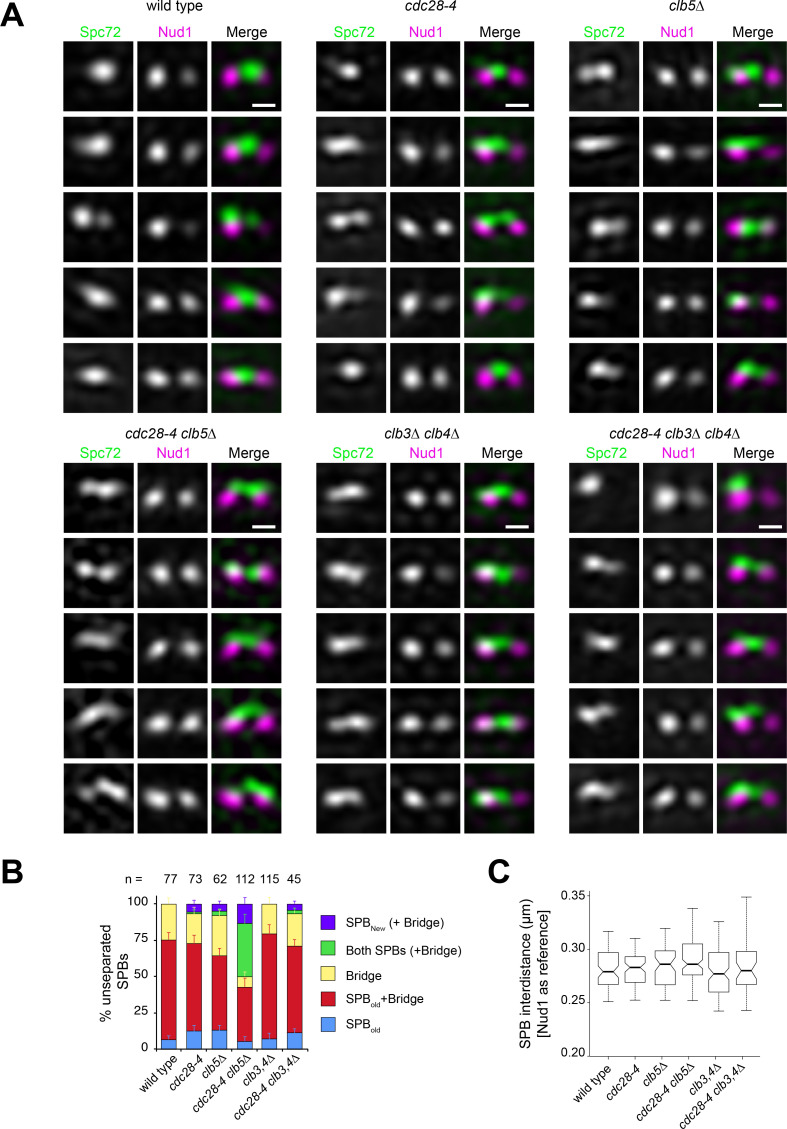
S phase CDK inactivation anticipates Spc72 recruitment at the new outer plaque in unseparated SPBs.Wild-type and cdc28-4 and cyclin mutant strains containing Spc72-Venus (green) and Nud1-mT2 (magenta) were imaged by SIM and subject to 3-D Gaussian fit and realignment, in reference to Nud1, to determine the distribution of Spc72 relative to Nud1. (A) Representative SIM images showing unseparated SPBs. Scale bar, 200 nm. (B) Quantitation of Spc72 distribution in all strains analyzed. Bars, standard error of the proportion. (C) Boxplot for distance between Nud1 unseparated foci for all cells analyzed. Boxplots depict the 5th, 25th, 50th, 75th and 95th centiles. Notches represent 95% CI of the median.